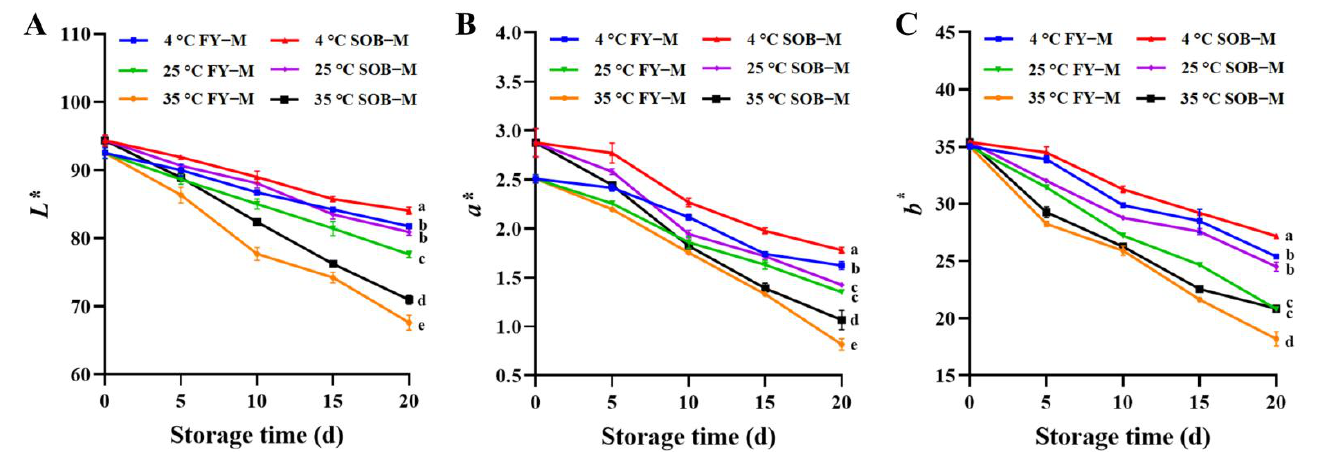
Figure 5. The ( A ) light-dark value, ( B ) red-green value, and ( C ) yellow-blue value of full egg yolk mayonnaise (FY − M) and SOB-substituted mayonnaise (SOB − M) during storage. Different lowercase letters indicated a significant difference ( p < 0.05).